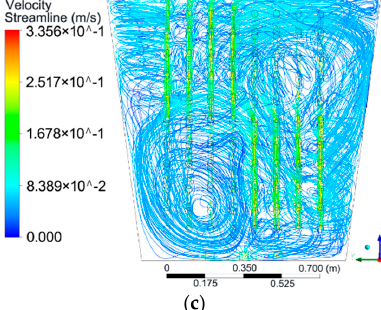
Figure 7. Stream-line illustration of the flow field between the baffles in the tundish with the MHDB in different hole array modes. ( a ) UILO mode; ( b ) LIUO mode; ( c ) X mode.